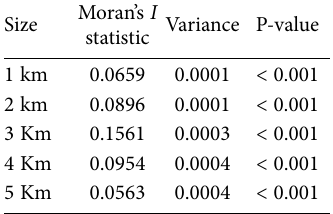
Table 2 . Moran’s I statistics for resi- duals of predictions in Poisson